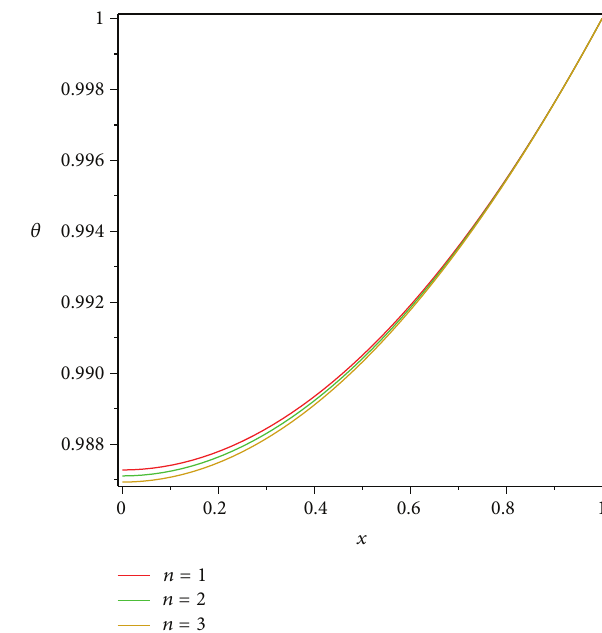
Figure 8: Temperature distribution for the profile 𝑓(𝑥) = 1, 𝑛 ̸= 𝑚 as given in solution (41) in a fin with varying values of 𝑀 .